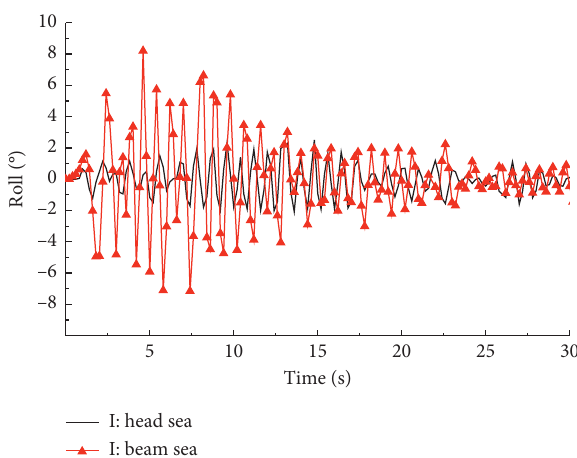
Figure 14: Time series of ship roll motion under different wave directions without mooring